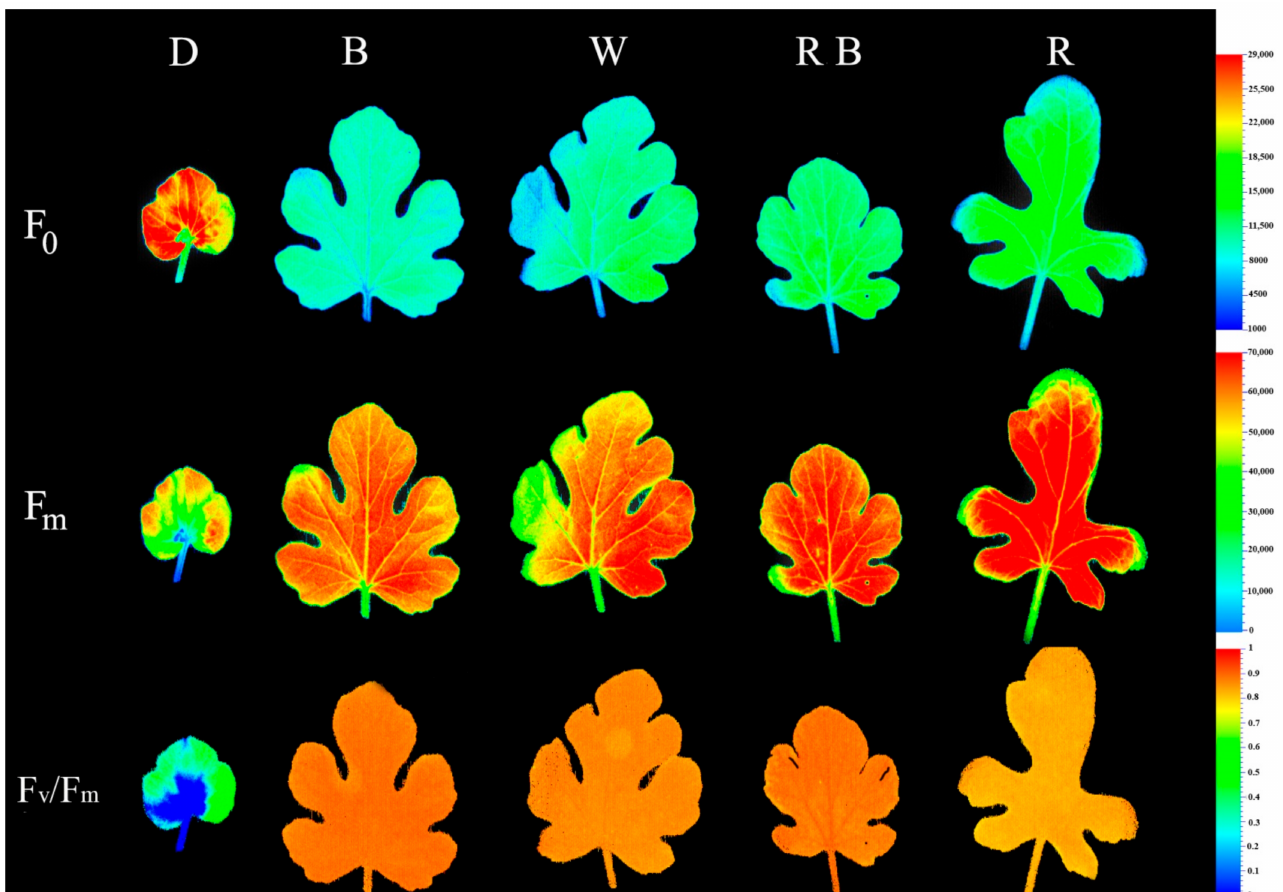
Figure 4. Pseudo-color images of F 0 , F m , and F v /F m (equations in Table 2) exhibited by leaves sampled from grafted watermelon seedlings exposed for 12 days to either darkness (D) or different light quality regimes [blue (B), white (W), red and blue (RB), as well as red (R); see spectrum in Supplementary Figure S3]. Photosynthetic photon flux density was 20 ± 1 µ mol m − 2 s − 1 during the first 2 days, and 50 ± 1 µ mol m − 2 s − 1 during the following days. Results from all nine plants were similar, representative images are